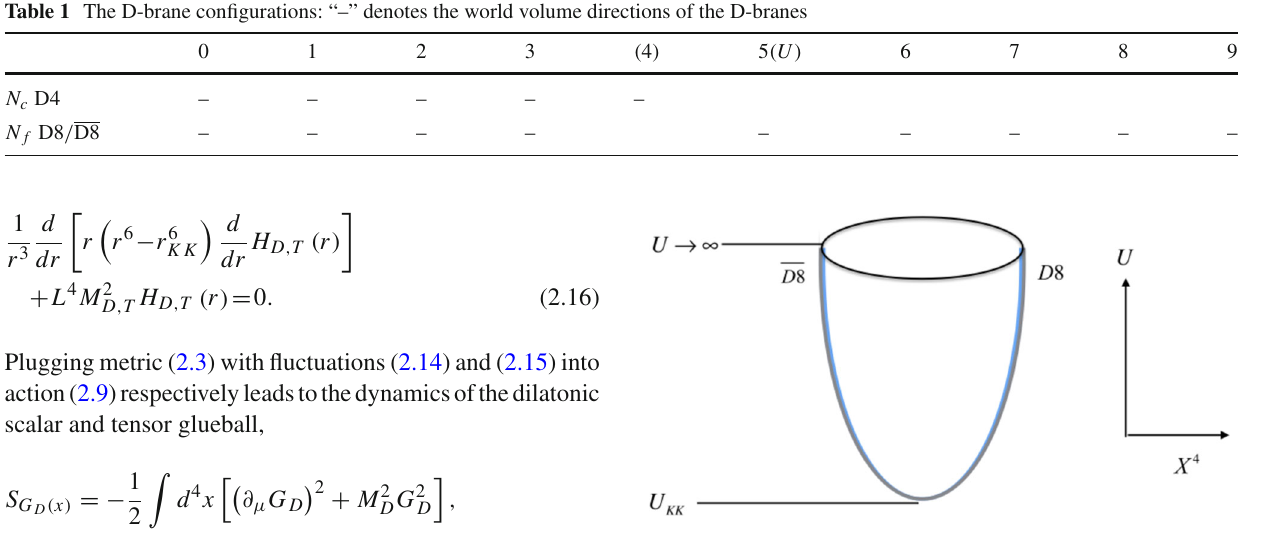
Fig. 1 The D-brane configuration in the X 4 − U plane where X 4 is compactified on S 1 . The bubble background (cigar) is produced by N c D4-branes . The N f light flavour D8 / D8-branes (L) living at antipodal positionofthecigararerepresentedbytheblueline.TheD8 / D8-branes are connected to each other at the bottom of the bulk ( U = U KK )